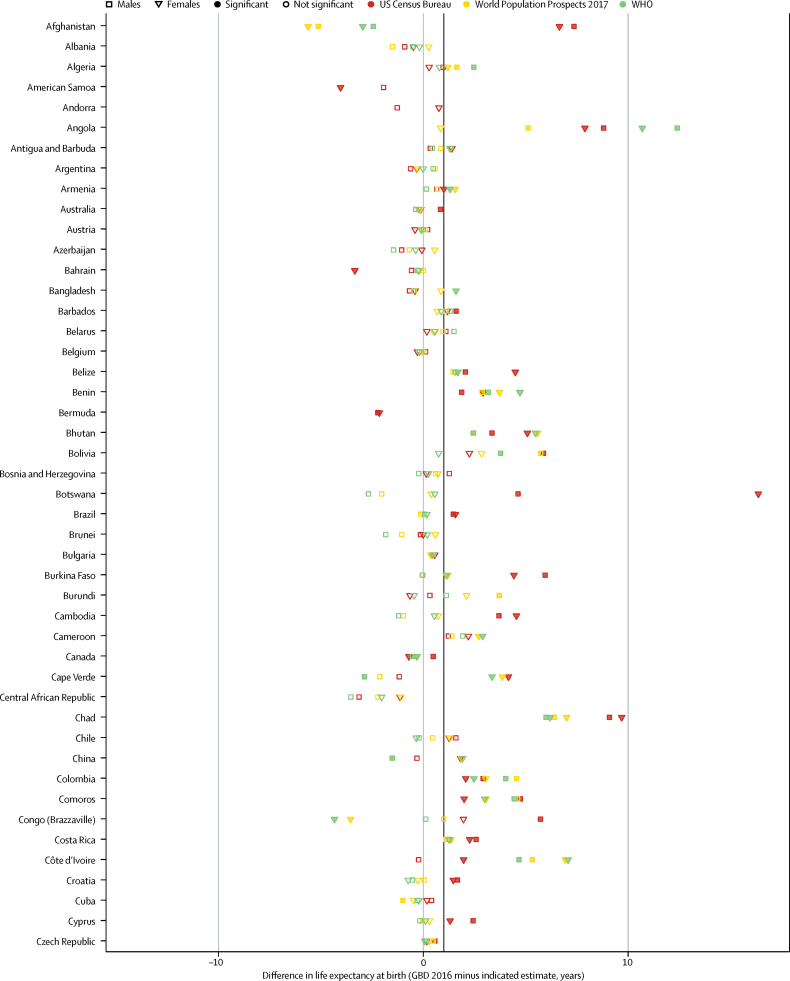
Difference in estimates of life expectancy at birth between GBD 2016 and other sources, 2015Each point represents the difference between GBD 2016 estimates of life expectancy at birth minus the life expectancy at birth estimated by the indicated sources for each country in 2015, the most recent year with estimates by all sources, by sex. Points are colour-coded by source with squares representing males and triangles representing females. The line at 0 represents no difference between the life expectancy at birth calculated in GBD 2016 and that calculated by the indicated source.